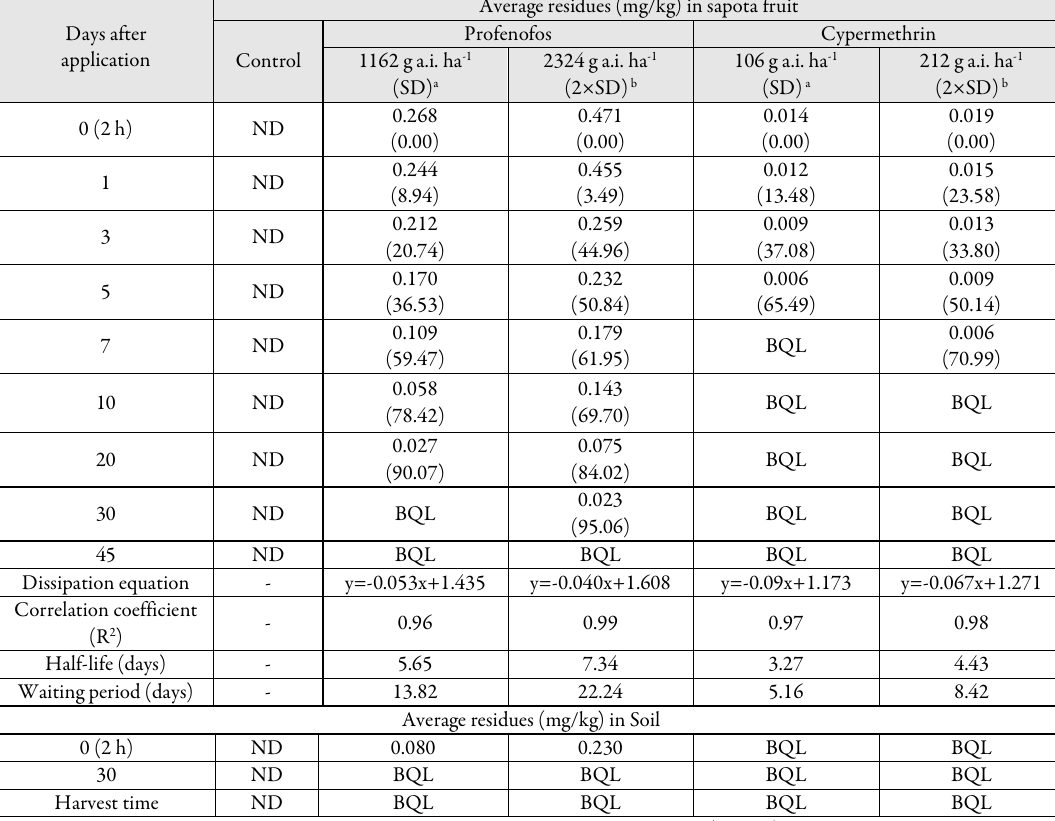
Table 2 Residues and percent dissipation of profenofos and cypermethrin in/on sapota fruit and soil